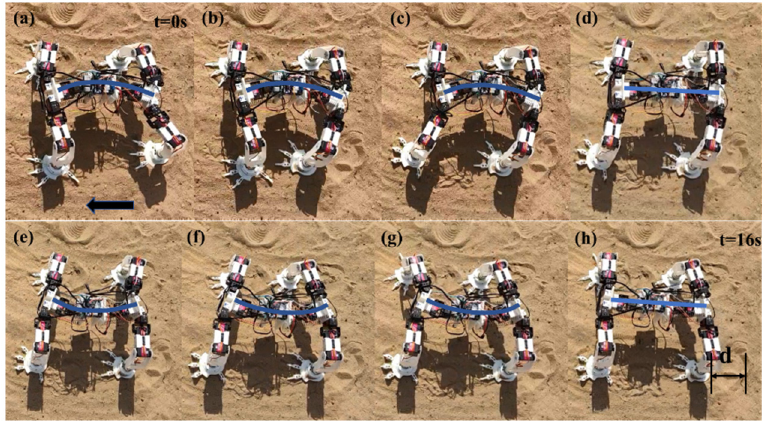
Figure 18. Tripod gait test; ( a – h ) eight movements in one locomotion cycle.